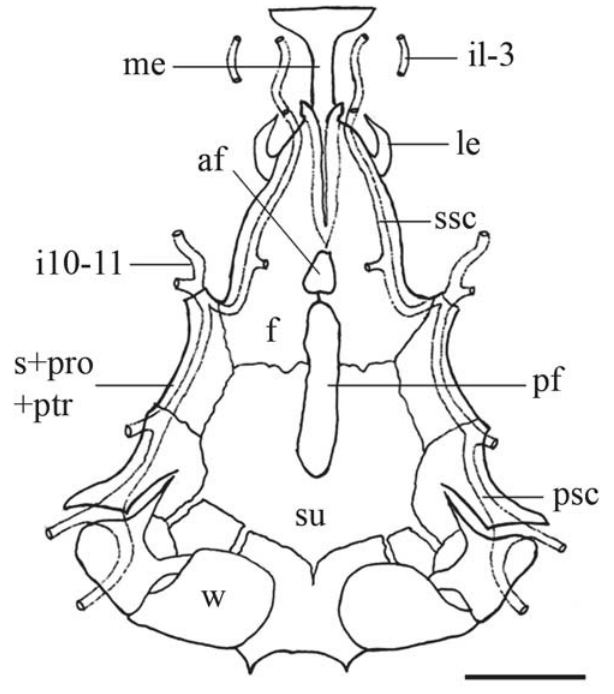
Fig. 4. Dorsal view of the neurocranium of Trichomycterus uisae . CAC-CDMB 90, 32.1 mm SL. af: anterior fontanel; f: fron- tal; i1-3: infraorbital sensory pores 1-3; i10-11: infraorbital sen- sory pores 10-11; le: lateral ethmoid; me: mesethmoid; pf: pos- terior fontanel; psc: postotic sensory canal; s+pro+ptr: sphe- notic+ prootic+pterosphenoid; su: supraoccipital; ssc: supraor- bital sensory canal; w: Weberian capsule. Scale bar =1